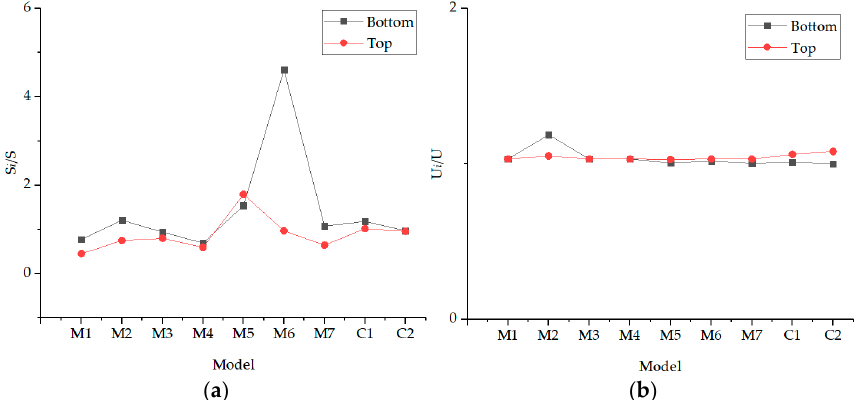
Figure 17. Comparison of stress and displacement between DHSB and UDHSB: ( a ) Stress multiple comparison diagram; ( b ) Displacement multiple comparison diagram.